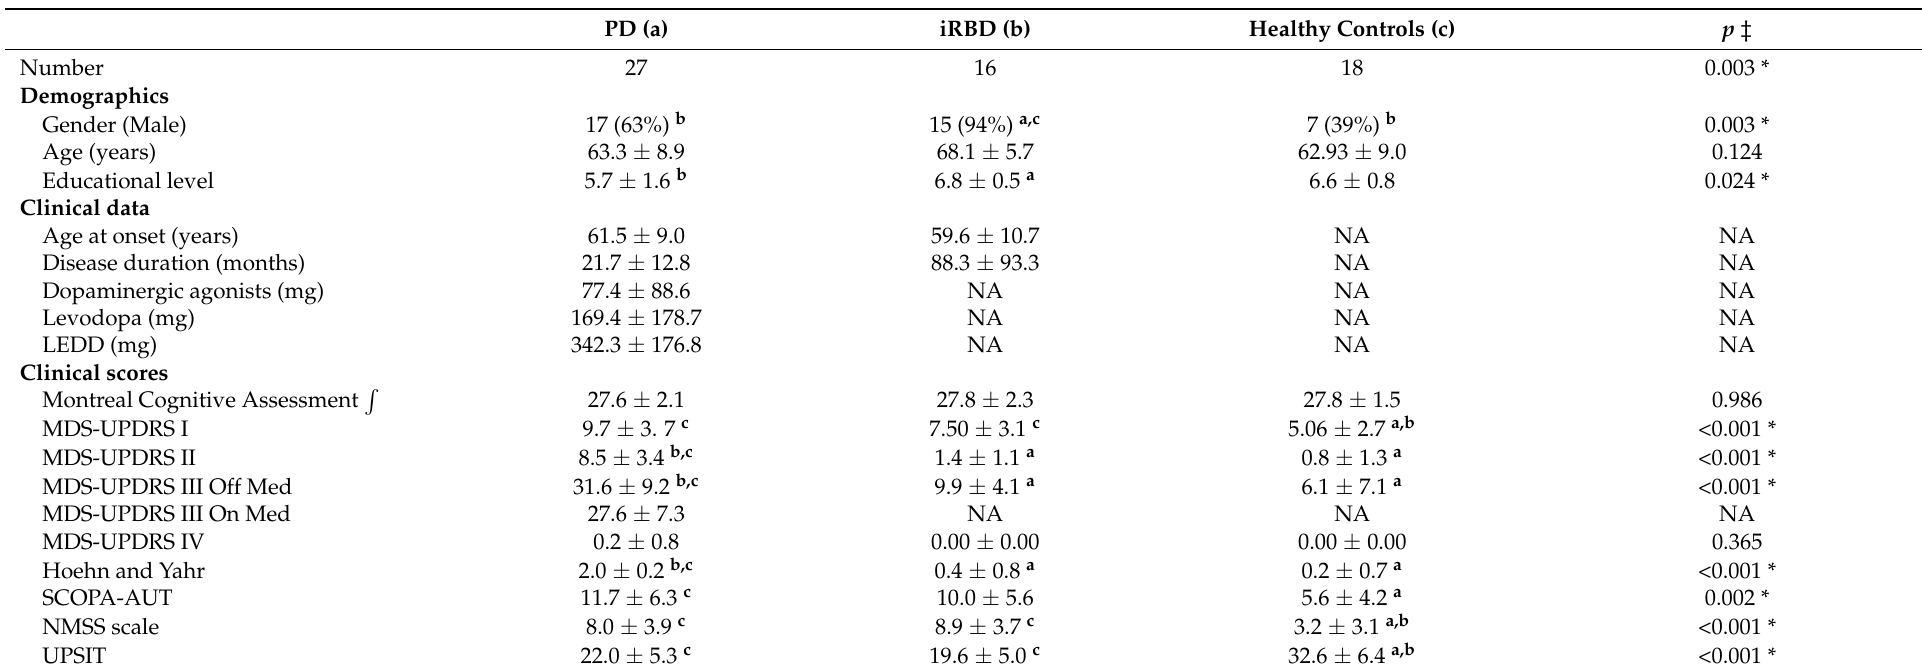
Table 1. Demographic, clinical, biopsies, and MRI measures in patients with Parkinson’s disease (PD) and with isolated rapid eye movement sleep disorder (iRBD) as well as in healthy